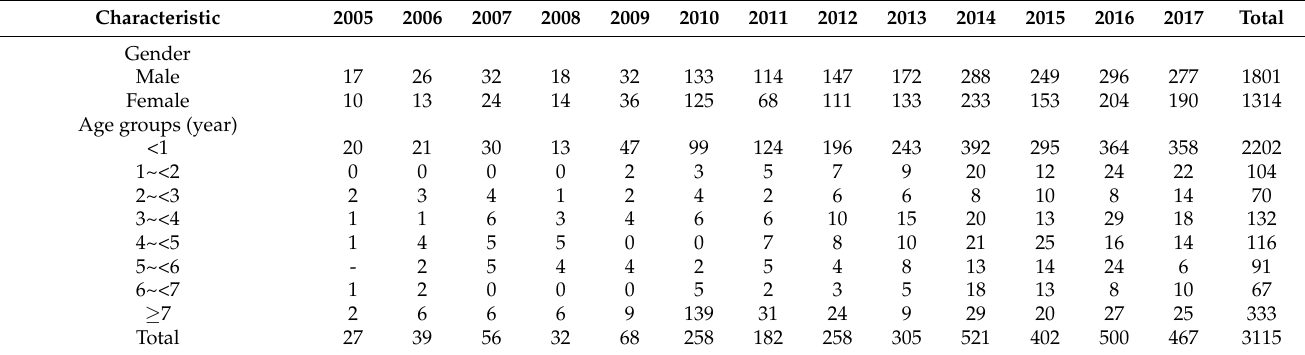
(n = 69), sterile abscess (n = 31), angioedema (n = 24), thrombocytopenic purpura (n = 21), and maculopapular rash (n = 20). The lowest incidence of rare vaccine reactions